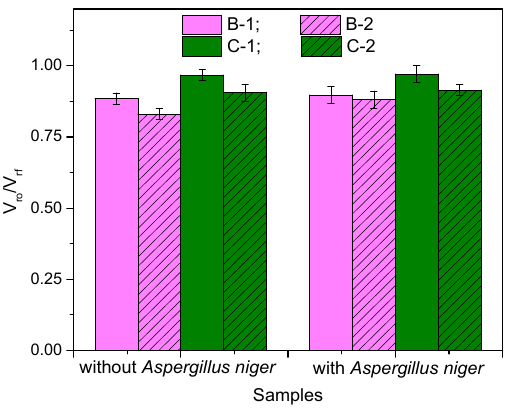
Figure 7. V r 0 / V rf ratio of the composites before and after incubation with Aspergillus niger .